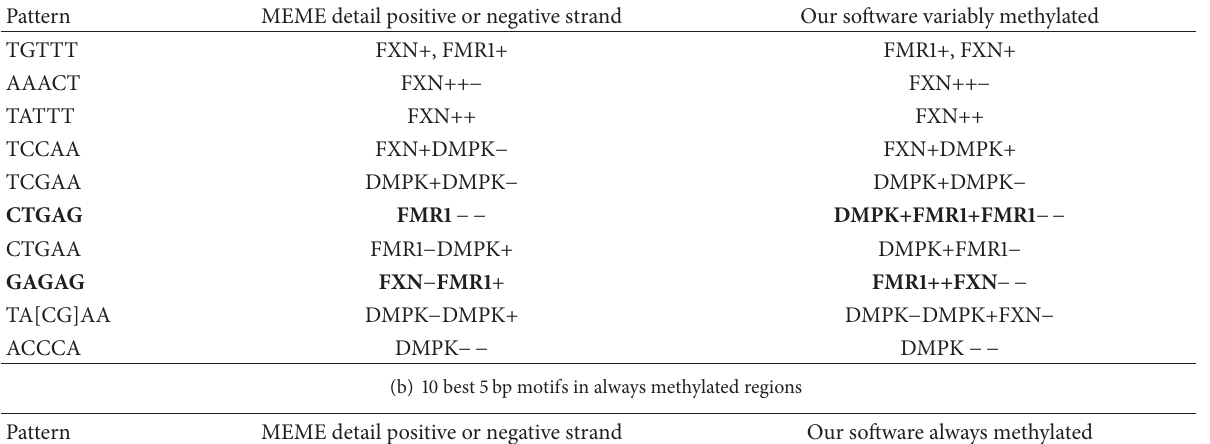
Table 3: Comparison of MEME results with patterns found in this